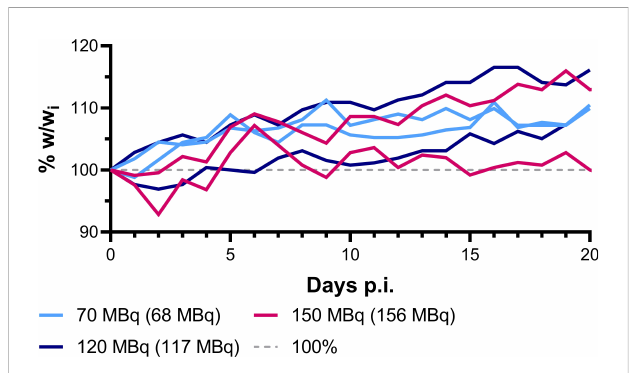
FIGURE 2 64 Cu-DOTHA 2 -PSMA maximal tolerated IA experiment mice follow- up, weight (w) follow-up. (w i : initial